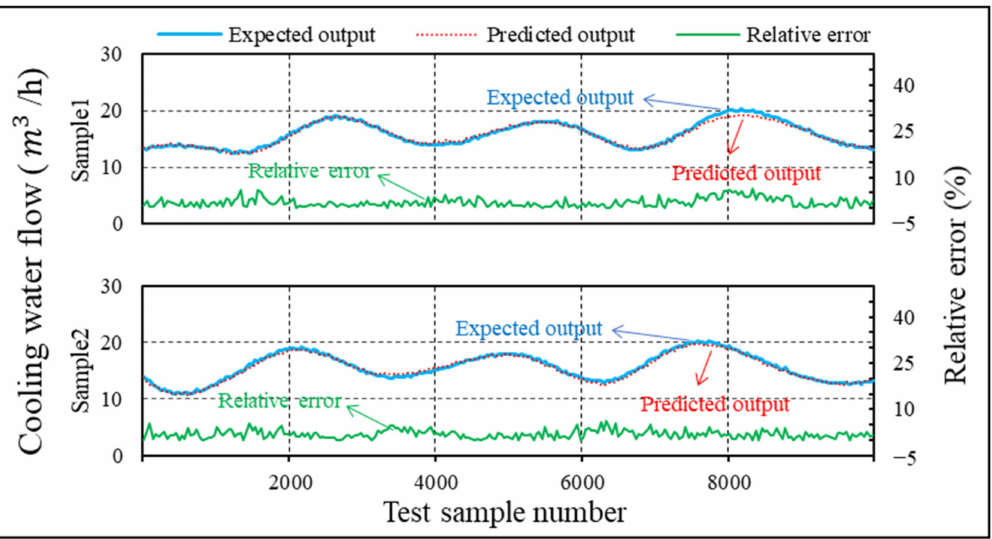
Figure 11. Predicted cooling water flow by